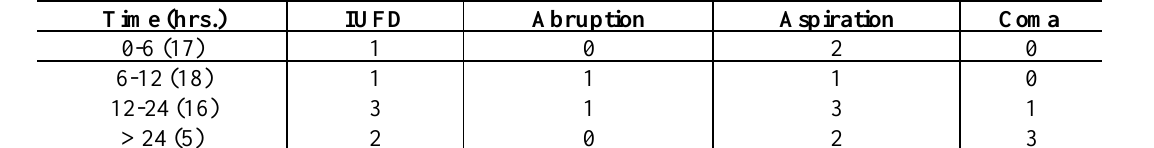
Table IV : Fetomaternal complications detected on arrival to BPKIHS (n = 56) Time